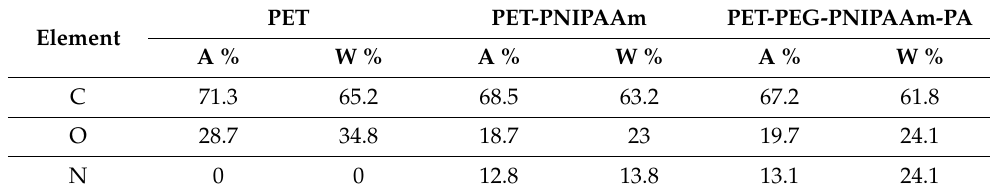
Table 2. Elements fraction (in atom and weight percent) from EDX for the different membranes. Element